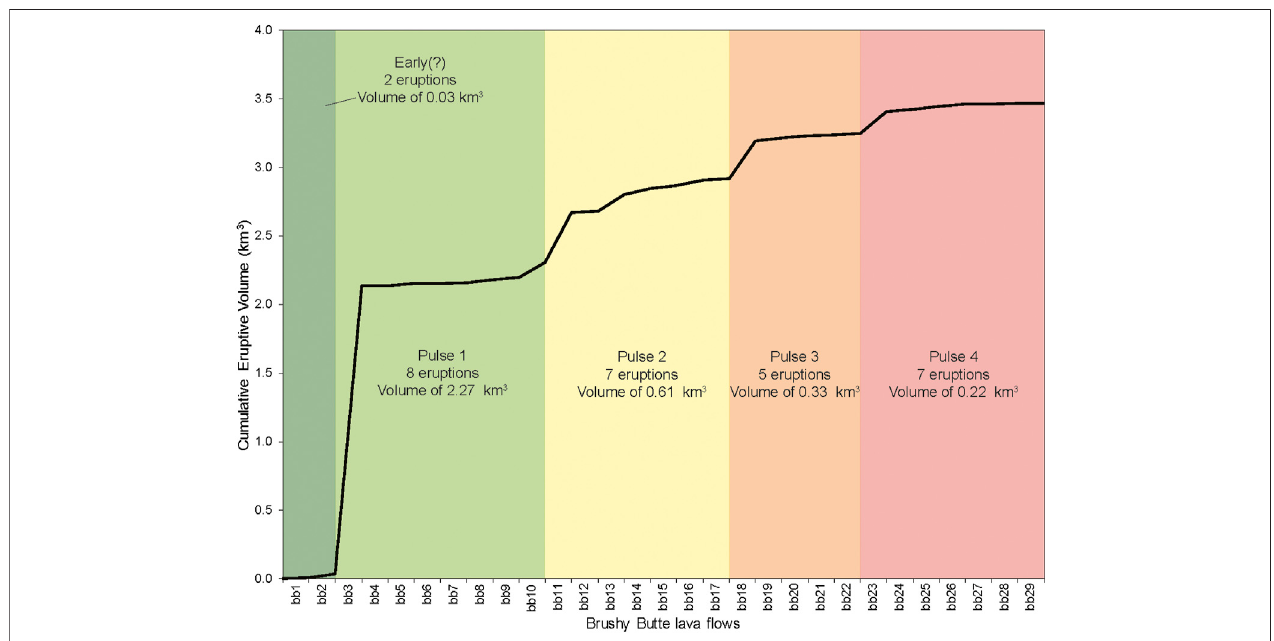
FIGURE7| Plotofcumulativeeruptivevolume(inkm 3 )fortheBrushyButte fl ow fi eld(unitsbb1 – bb29).Thefourdistinctpulsesbasedonstratigraphicorderof fl ows and eruptive volume are highlighted by different